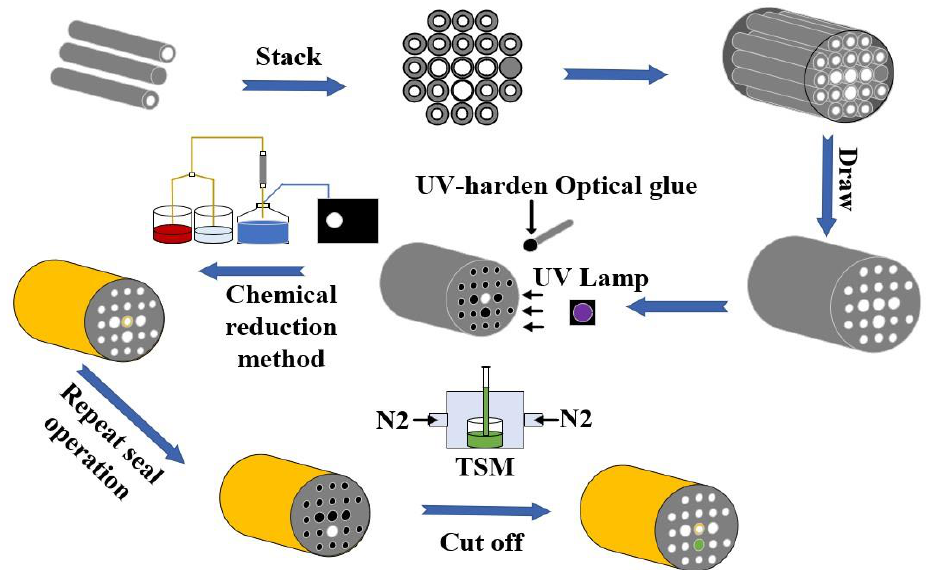
Figure 14. The schematic diagram of the proposed SPR-based PCF sensor fabrication.